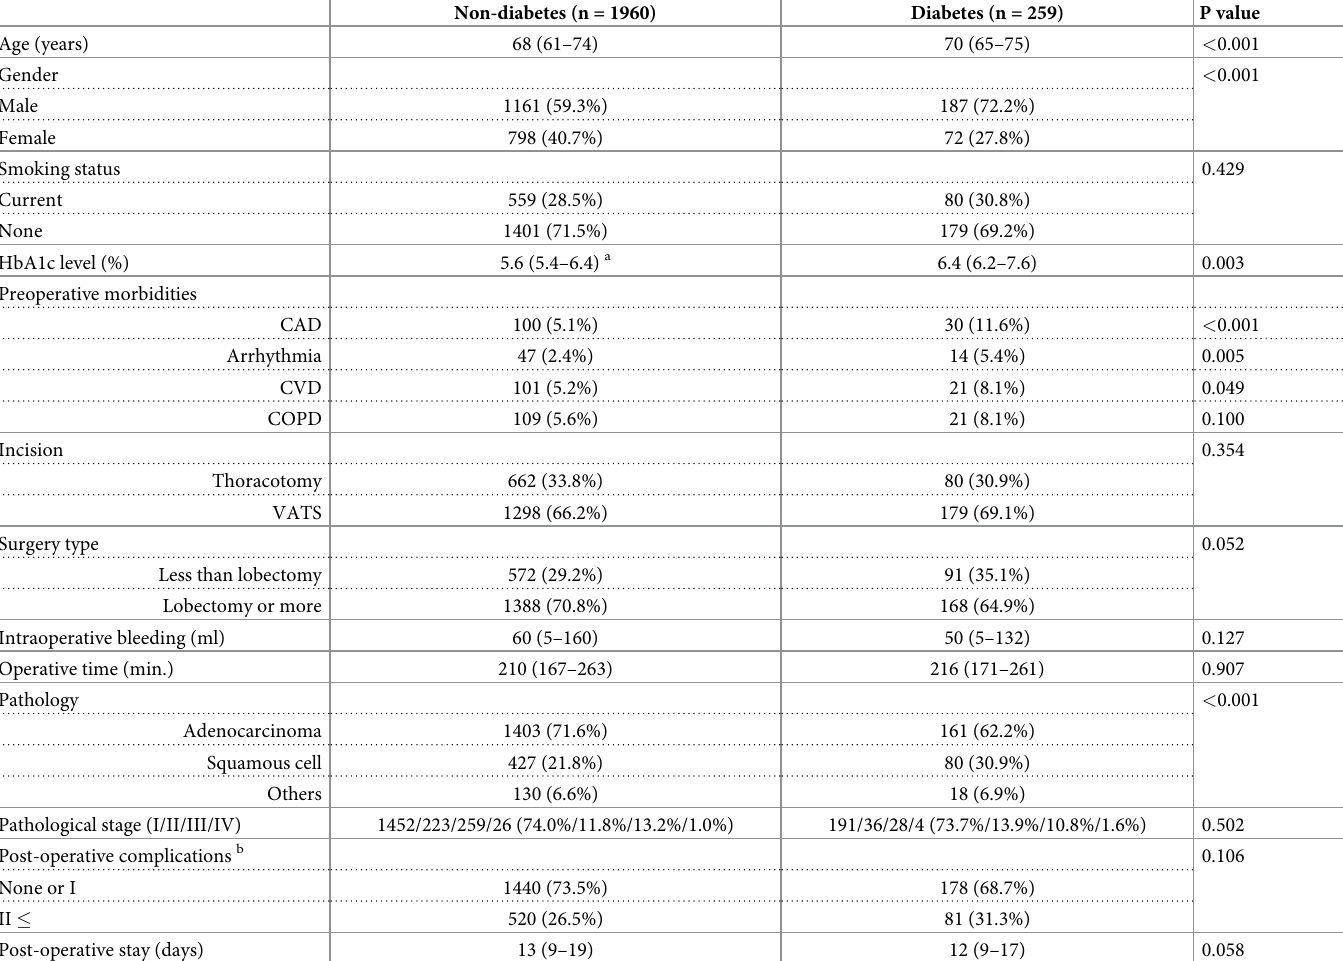
Table 1. Characteristics of the 2219 patients (Non-diabetes vs diabetes) including Post-operative stay and complications. Non-diabetes (n = 1960) Diabetes (n =